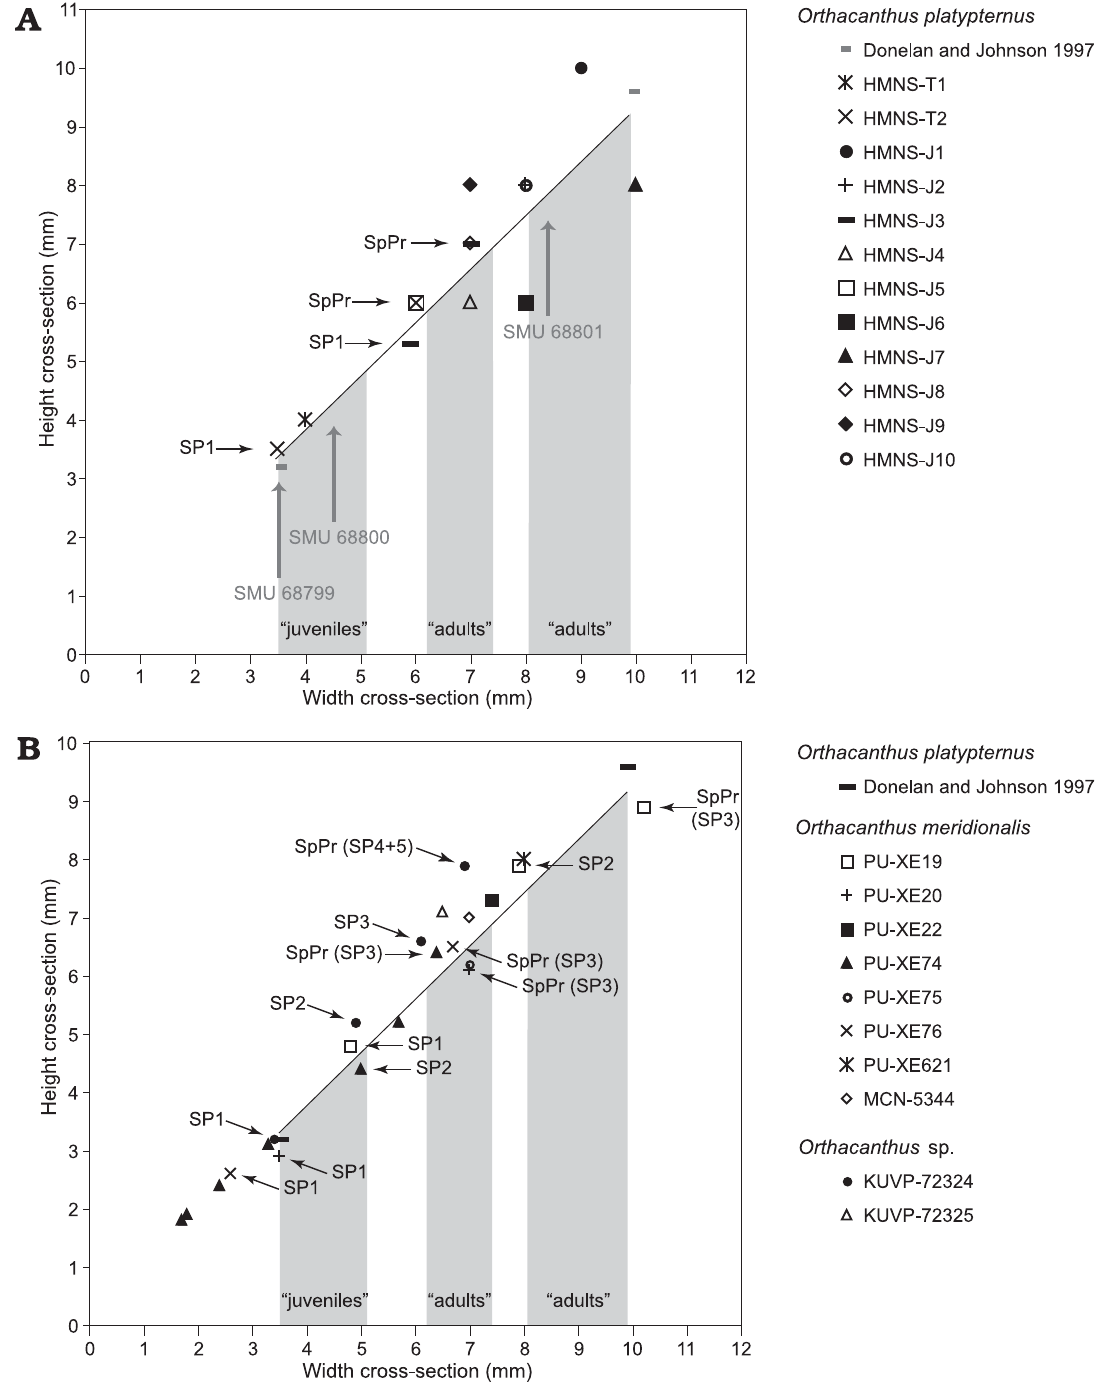
Fig. 9. Bivariate plots of relationship between width and height in cross sections of Orthacanthus dorsal spines. A . Orthacanthus platypternus (Lower Permian, Craddock Bone Bed, Texas, USA). B . Comparison of O. platypternus with O. meridionalis (Upper Carboniferous, Puertollano, Spain) and Orthacanthus sp. (Upper Carboniferous, Robinson, Kansas, USA). Note the linear regression (y = 0.91x + 0.15; n = 65, r 2 = 0.98) calculated by Donelan and Johnson (1997) for the isolated dorsal spines of O. platypternus . The maximum and minimal values are also included here for a comparative reference; values of the rest of the specimens are not included for clarity. Grey shaded areas indicate approximate intervals of the three size clusters corresponding to juveniles and adults according the biometric analysis by Donelan and Johnson (size intervals are based on unpublished data presented in a poster at 57th Annual Meeting of the Society of Vertebrate Paleontology, Chicago, October 1997). Note the ontogenetic trajectories of several individuals of O. platypternus (HMNS-T2 and HMNS-J3), O. meridionalis (PU-XE19, 20, 74 and 76) and Orthacanthus sp. (KUVP-72324) showing stages SP1–n (spine proper). Data from O. meridionalis and Orthacanthus sp. after Soler-Gijón (1999: table 1 and figs. 4–8). Vertical grey arrows point to the position in the linear regression for SMU specimens according the maximum width values at the proximal end of denticulated regions: 3.5 mm (SMU 68799), 4.5 mm (SMU 68800) and 8.4 mm (SMU 68801). Abbreviations: SP1–5, spines 1–5; SpPr, spine